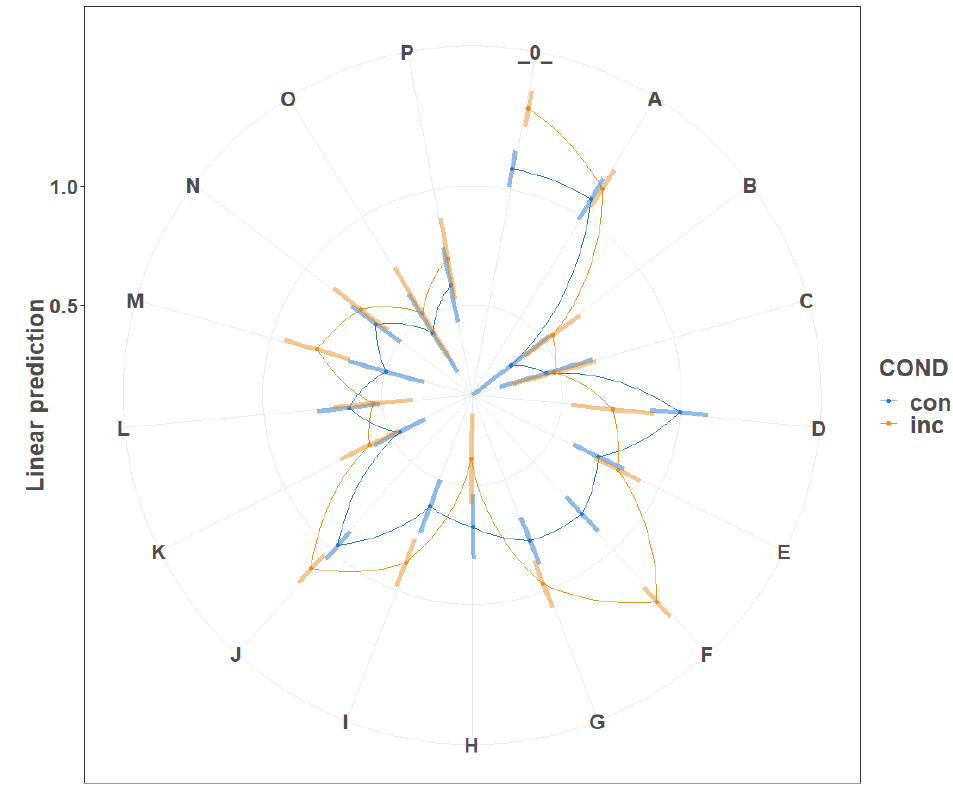
Figure 8. Mixed model of binary stimuli conditions on the emospace widget response.